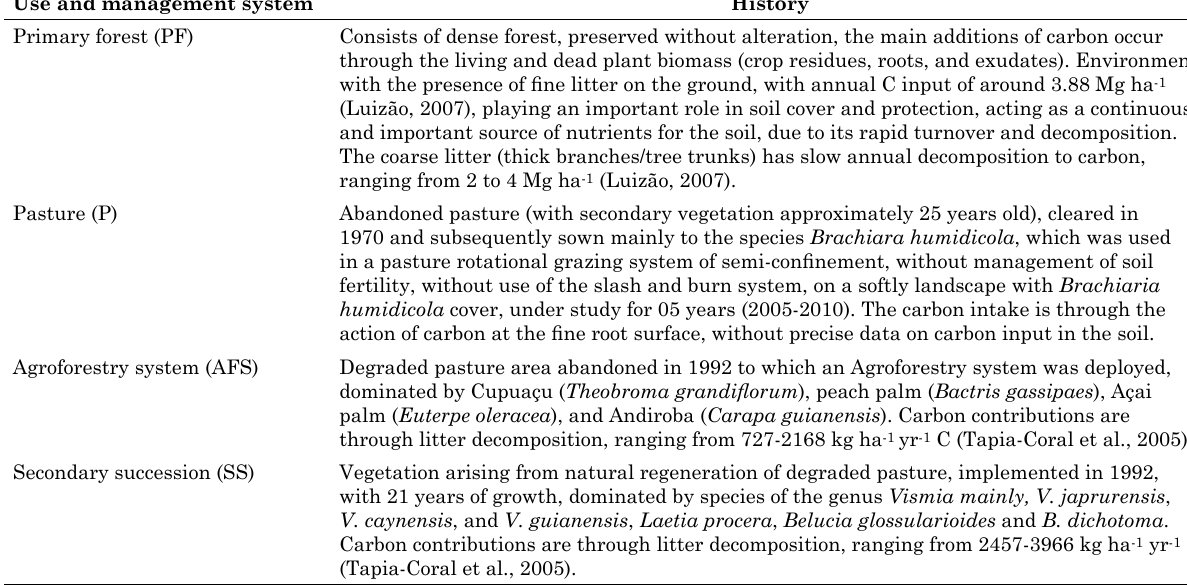
Table 1. Characteristics of the use and management systems